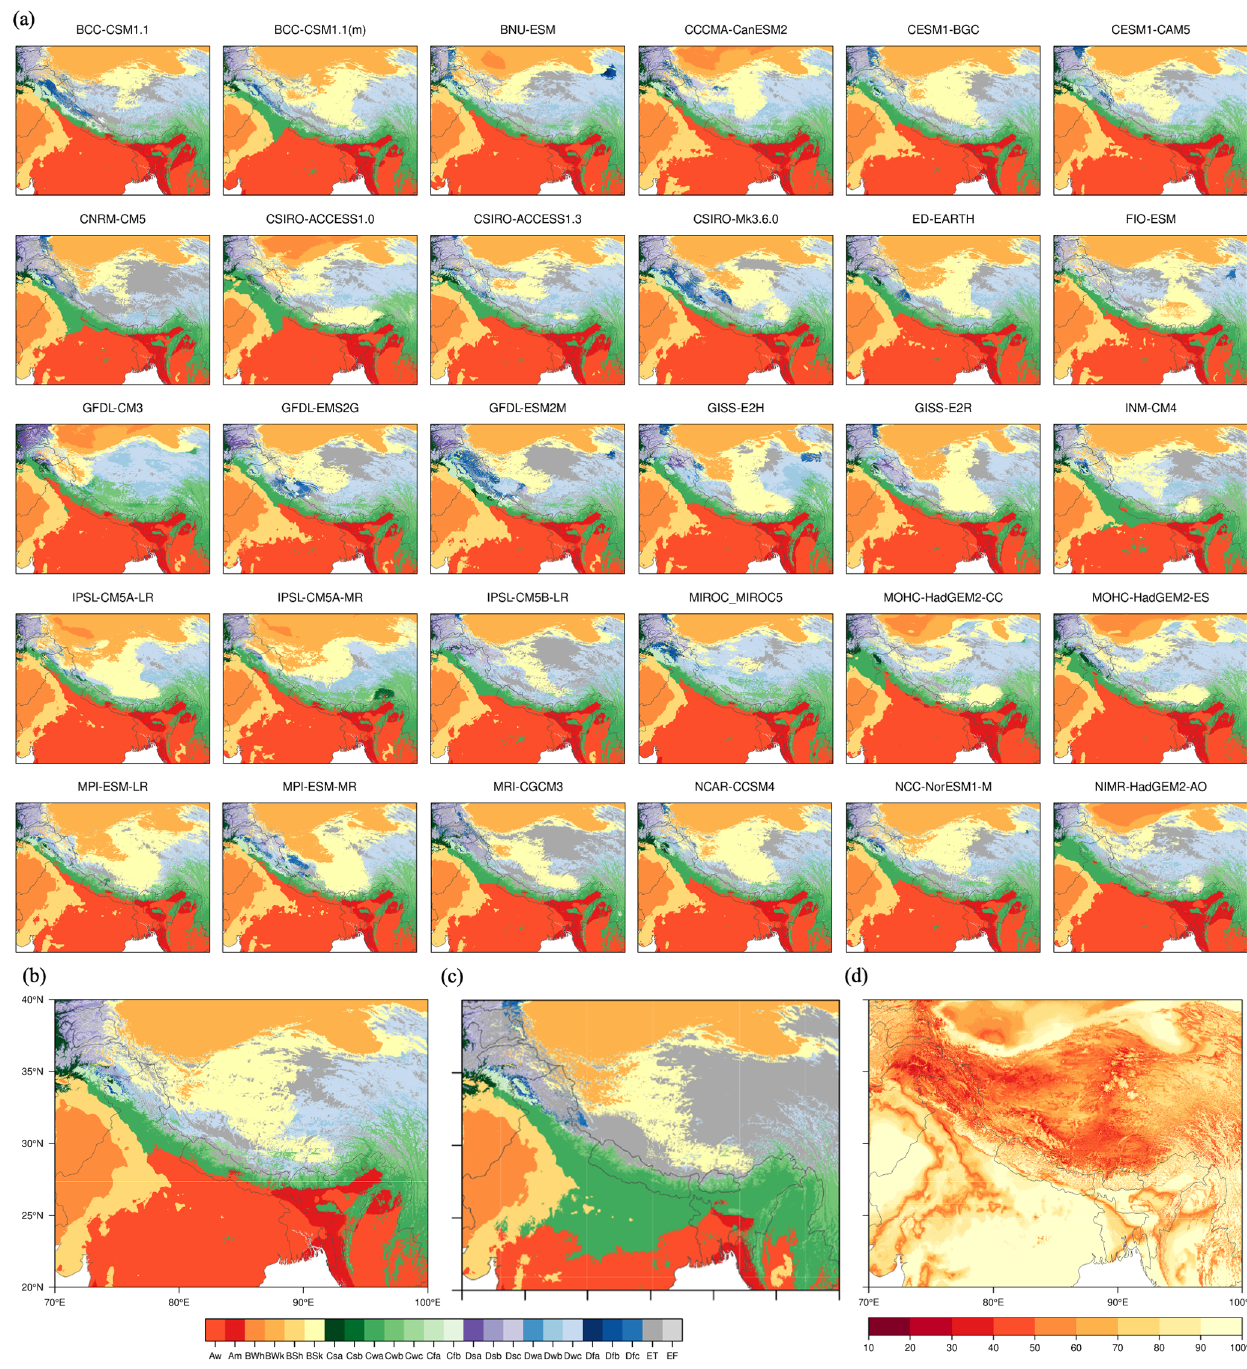
Figure 13. Future Köppen–Geiger classification and confidence map for 2060–2089 under RCP8.5 with resolution of 1km for the Tibetan Plateau. (a) Climate maps based on 30 GCMs, (b) the final climate map derived from the most common climate class among all 30 climate maps, (c) present climate map of 1979–2008, and (d) confidence level distribution of the final climate